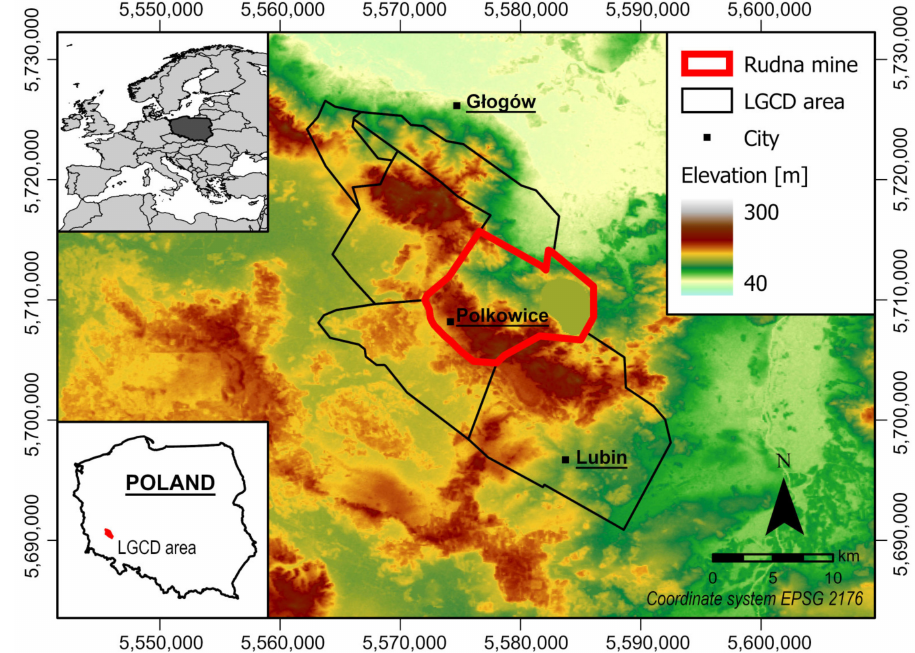
Figure 1. Location of the Rudna underground copper ore mines (Poland), one of the largest underground copper mining operations in the world. Map background: Shuttle Radar Topography Mission (SRTM) Digital Elevation Model, resolution 30 m.